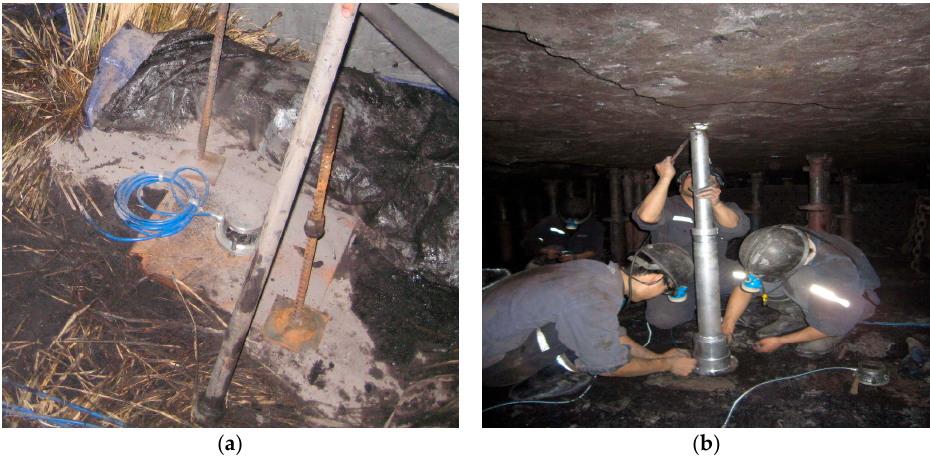
Figure 13. Pictures of the site equipment installation: ( a ) a stress sensor and ( b ) a displacement sensor.